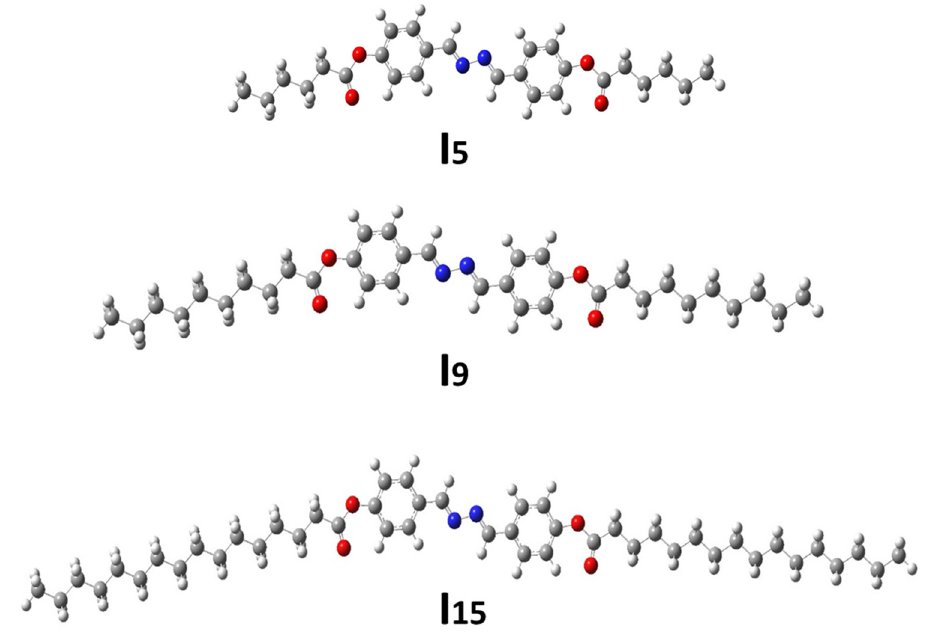
Figure 4. The optimized molecular structures of the investigated I n series, predicted at B3LYP/6-311G** level. Table 2. Estimated thermal parameters for the investigated I n series.